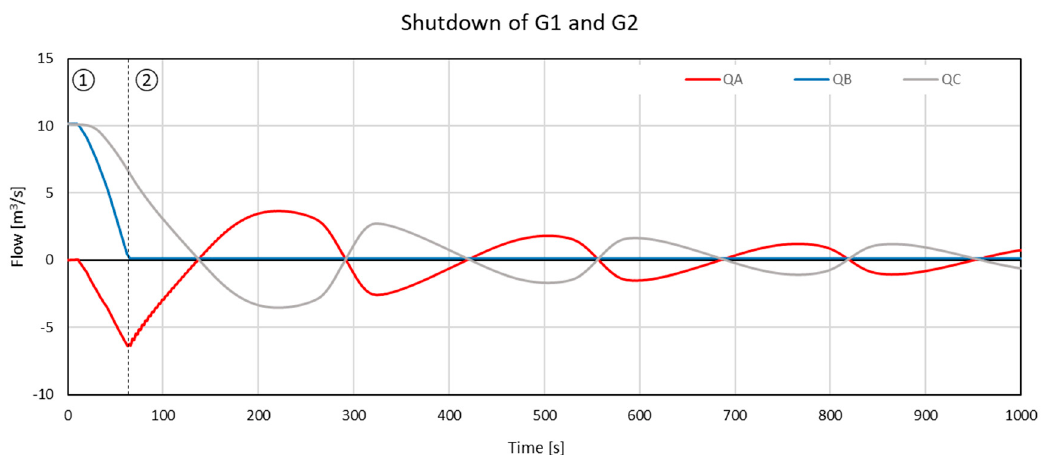
Figure 11. Flows through the three branches during loading of G1 and G2.